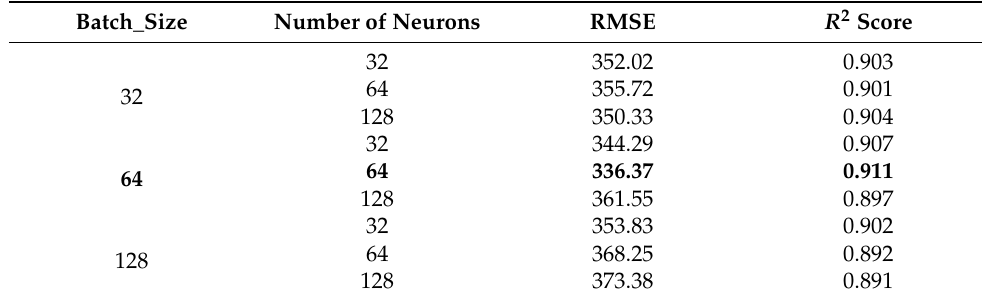
Table 3. Experimental results (time_step =